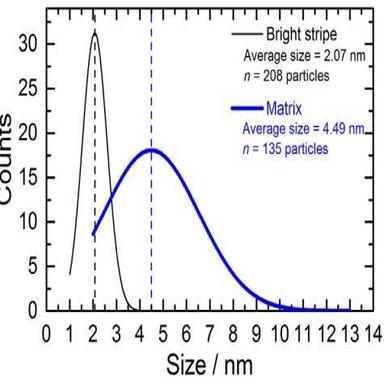
Size distribution of the nano-particles in the bright stripe and matrix region of ODS_WQ_RT where n is the number of nano-particles examined.